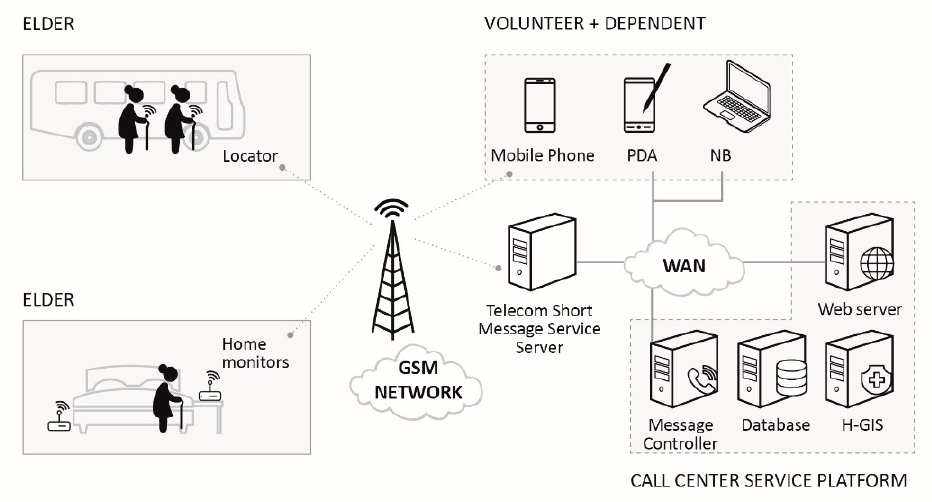
Figure 2. Service health management care system architecture. (Adapted from Lin et al. [23]).